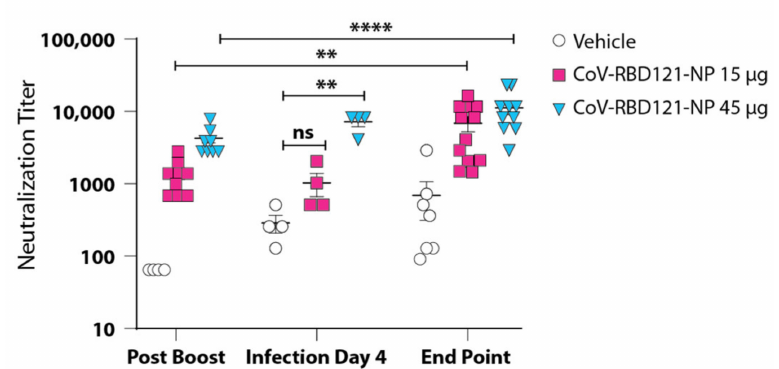
Figure 4. Neutralizing antibody titers in vaccinated mice after challenge with SARS-CoV-2. Titers of neutralizing antibodies were analyzed from serum collected from mice in each group at 4 days following challenge (Infection Day 4, n = 4 technical replicates of pooled sera from all mice in each group) or at day 10 or at death (End Point, n = 7 for vehicle, n = 10 for each vaccine group) following challenge. Post-boost values are the same as those shown in Figure 1A for ease of comparison. Data are plotted as mean ± SEM with values for each mouse shown. Significance was determined by